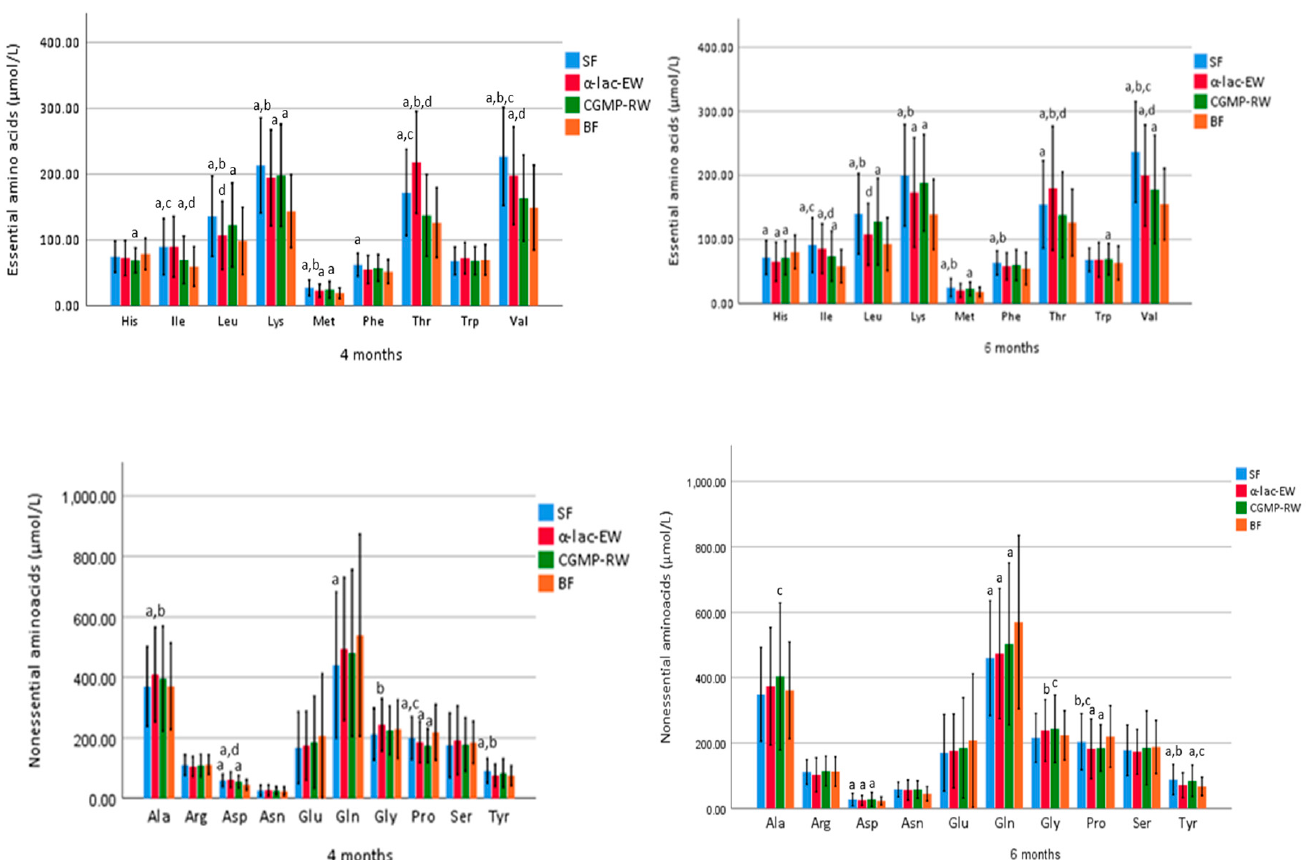
Figure 3. Mean ( ± SD) plasma concentration of essential and nonessential amino acids in the ran- domized subgroup (n = 50 in each group) at four and six months of age. Groups compared by one-way ANOVA, post hoc Bonferroni. p value < 0.05 are considered statistically significant and marked by superscript letters. a Significantly different vs. BF. b SF vs. α -lac-EW. c SF vs. CGMP-RW. d α -lac-EW vs. CGMP-RW. SF, standard formula; α -lac-EW, experimental formula with α -lactalbumin enriched-whey; CGMP-RW, experimental formula with reduced CGMP whey; BF, breast-fed. Mean total branched chain amino acids (BCAA—sum of isoleucine (Ile), leucine (Leu) and valine (Val)) was higher at four and six months in FF than in BF infants, but lower in α -lac-EW and CGMP-RW than in SF infants (Figure 4). Serum insulin and C-peptide were similar among the FF groups, and higher than in BF infants at baseline (except in α -lac-EW where insulin was similar to BF) and during the intervention period (Table 7). Serum IGF-1 was similar at baseline in all groups (except in α -lac-EW where S-IGF-1 was higher than in BF), but at four and six months was higher in all FF groups compared to BF infants. Weight gain per day was positively correlated with the difference in S-IGF1 concentration between two and six months in all FF infants (r = 0.32, p < 0.001), and also when analyzing the FF groups separately; SF (r = 0.26, p = 0.004), α -lac-EW (r = 0.31, p = 0.014), CGMP-RW (r = 0.37, p = 0.004), but no correlation was found among BF infants (r = − 0.076, p =